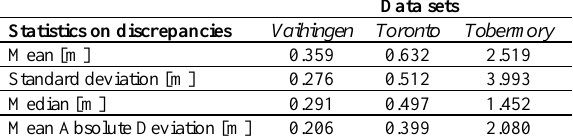
Table 3. Statistics on results obtained for the Vaihingen”, “Toronto” and “Tobermory” Data sets.